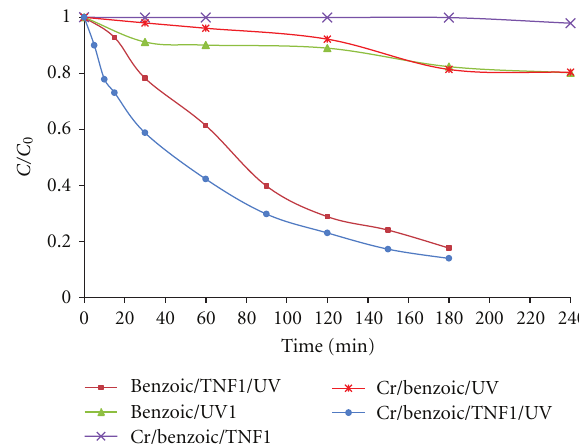
Figure 2: Photocatalytic degradation of benzoic acid in single and binary systems. ([Cr(VI)] 0 = 0.1 mM, [BA] 0 = 0.01 mM, pH = 2, N-F-TiO 2 = 500mg L − 1